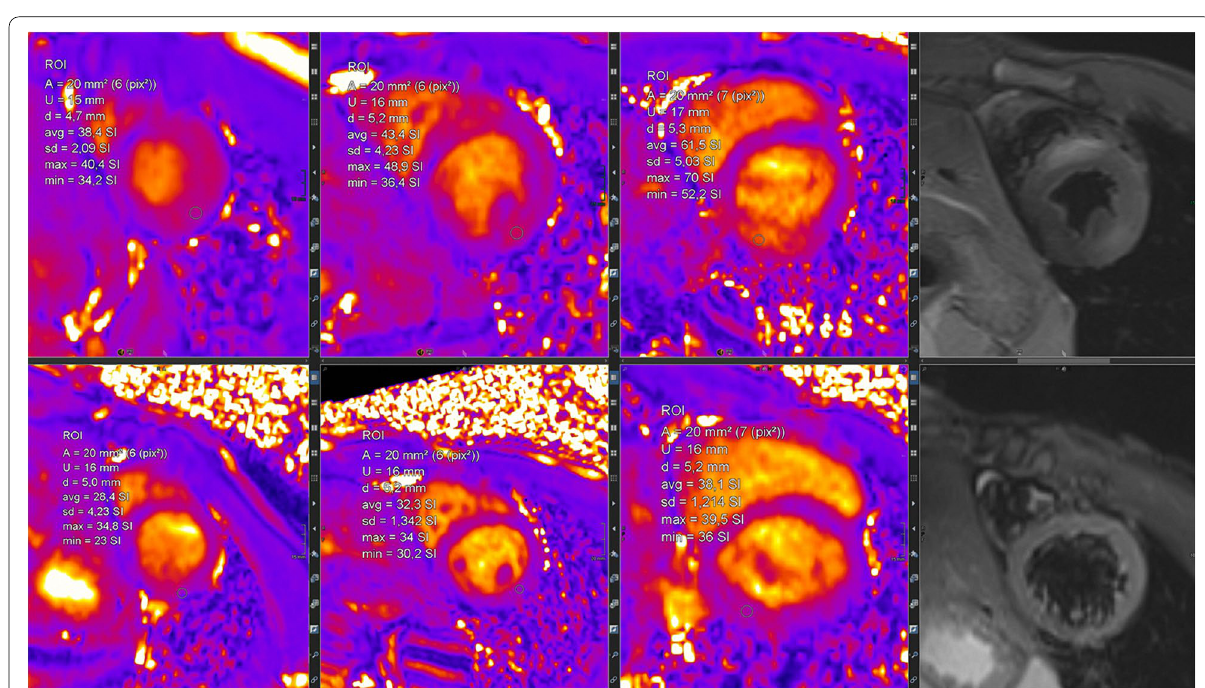
Fig. 17 (T2 mapping during follow-up): normalization of initially increased signal intensities in septal LV myocardium (upper row—baseline with 38–62 ms; lower row—follow-up with 28–38 ms). This further supports the mentioned post-acute myocarditis stage